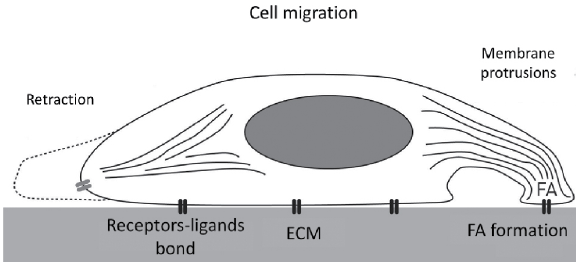
Figure 3: Simplified description of cell migration